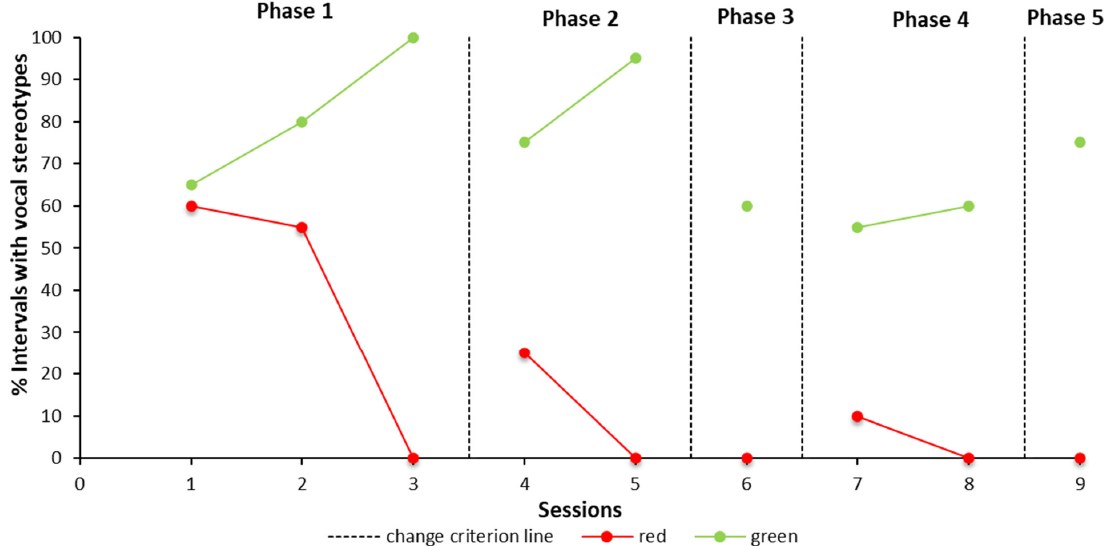
Figure 1. Discrimination Training, vocal stereotypies showed for both of the conditions (red card/green card) during five phases. Note: Percentage of 15-s intervals in which the child emitted the stereotyped vocal behavior. During phase 2 the red card was replaced with a red bracelet. The red lines represent the red card condition and the green lines the green card. The dotted lines (change criterion) represent the different phases where reinforcements (tangible and praise) were delivered through a variable interval schedule.